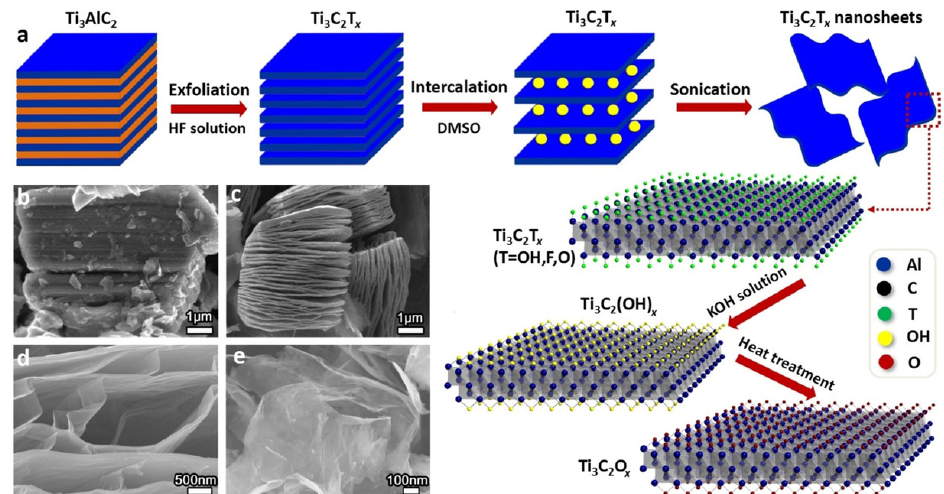
Figure 10. ( a ) Schematic for the fabrication of Ti 3 C 2 T x MXene and E-Ti 3 C 2 O x . SEM micrographs ( b ) of Ti 3 AlC 2 , ( c ) layered Ti 3 C 2 Tx, ( d ) layered Ti 3 C 2 T x intercalated with DMSO, and ( e ) E-Ti 3 C 2 Tx . Reproduced with permission from ref. [141] Copyright 2019, Willey.